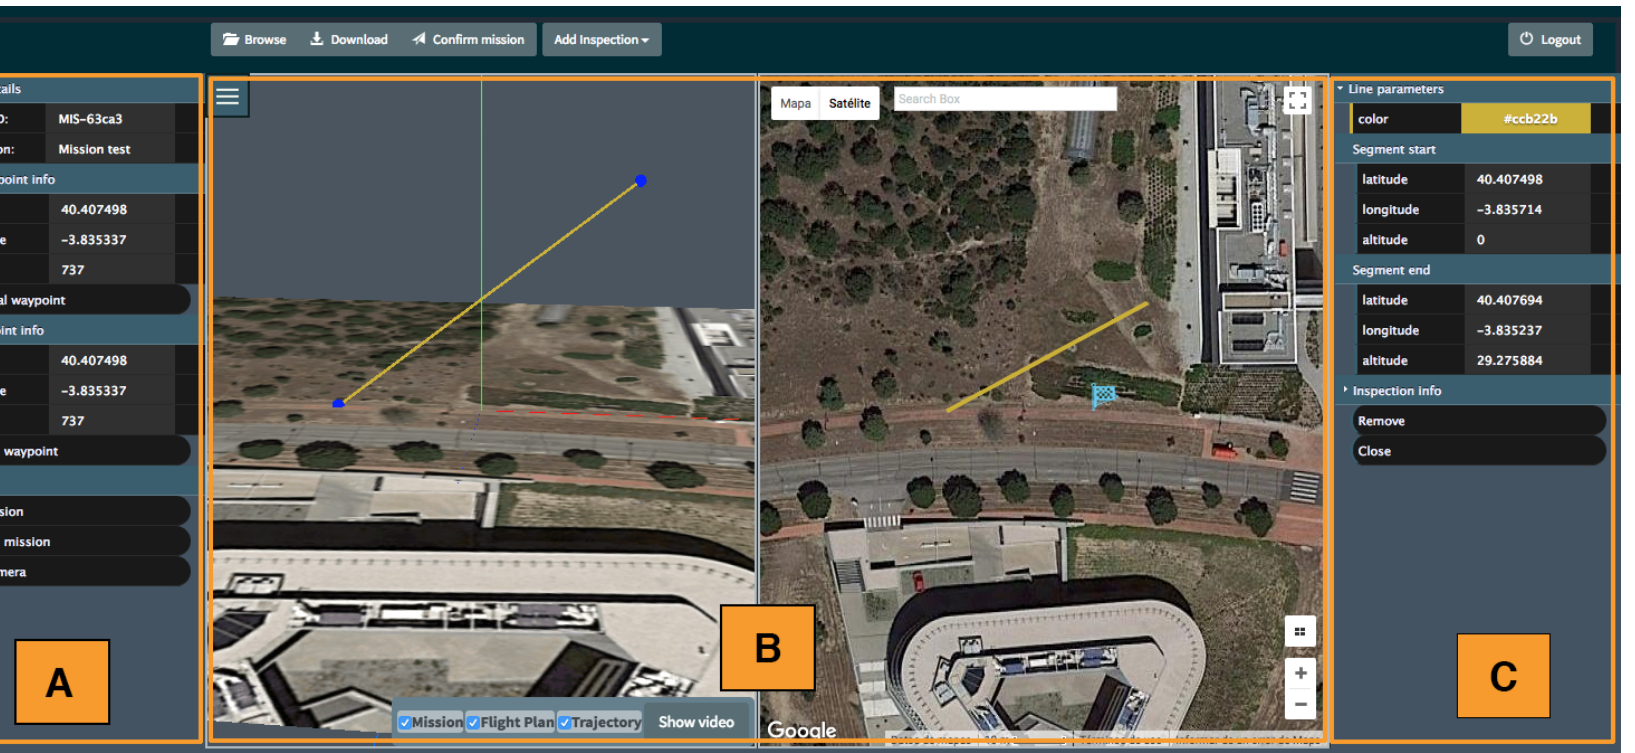
Figure 2. Main interface of the web